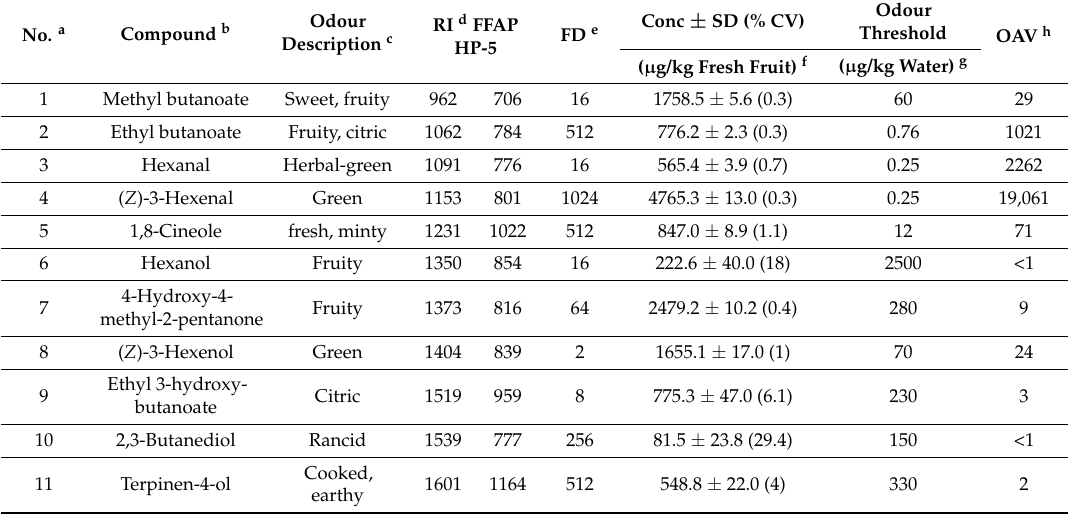
Figure 2. GC analyses on an FFAP column of the volatile compounds from yellow tamarillo fruit obtained by SAFE distillation. Numbers correspond to those in Table 1. Table 1. Odor-active volatile compounds detected in SAFE extract of yellow tamarillo ( Solanum betaceum Cav.) fruit.